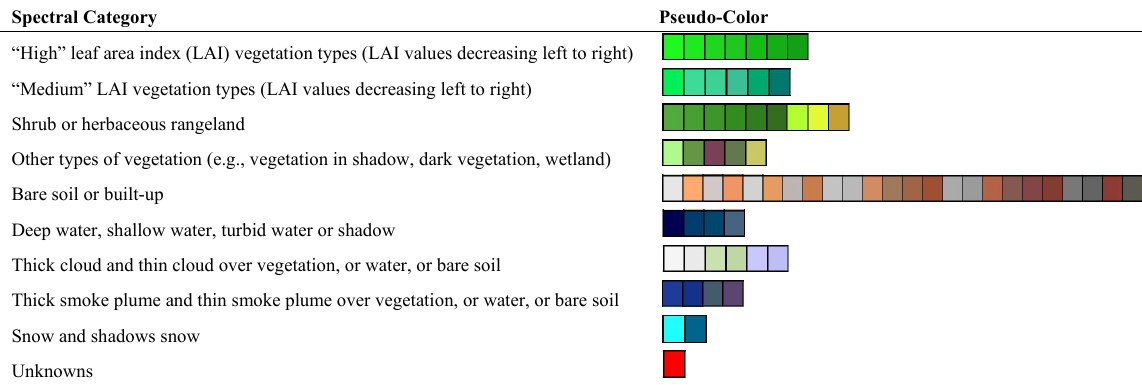
Table 3. Preliminary classification map’s legend, adopted by the SPOT-like SIAM™ (S-SIAM™) at fine semantic granularity, consisting of 68 spectral categories (refer to the Part 1, Table 4 [20]). Pseudo-colors of the spectral categories are grouped on the basis of their spectral endmember (e.g., “ bare soil or built-up ”) or parent spectral category (e.g., “high” leaf area index (LAI) vegetation types). The pseudo-color of a spectral category is chosen so as to mimic natural colors of pixels belonging to that spectral category. This legend gives a clue about the symbolic parent-child relationships supported by S-SIAM™ at different semantic granularity levels (refer to the Part 1, Figure 4 [20]). For example, a line-specific OR-combination of the 68 “child” spectral categories detected at the fine semantic granularity level across the 10 lines of Table 3 would provide 10 “parent” spectral categories at a coarser level of semantic granularity. Since it deals with symbolic reasoning, then this semantic aggregation is inherently subjective (equivocal) in nature, refer to the Part 1, Section 2.1 [20]. Spectral Category